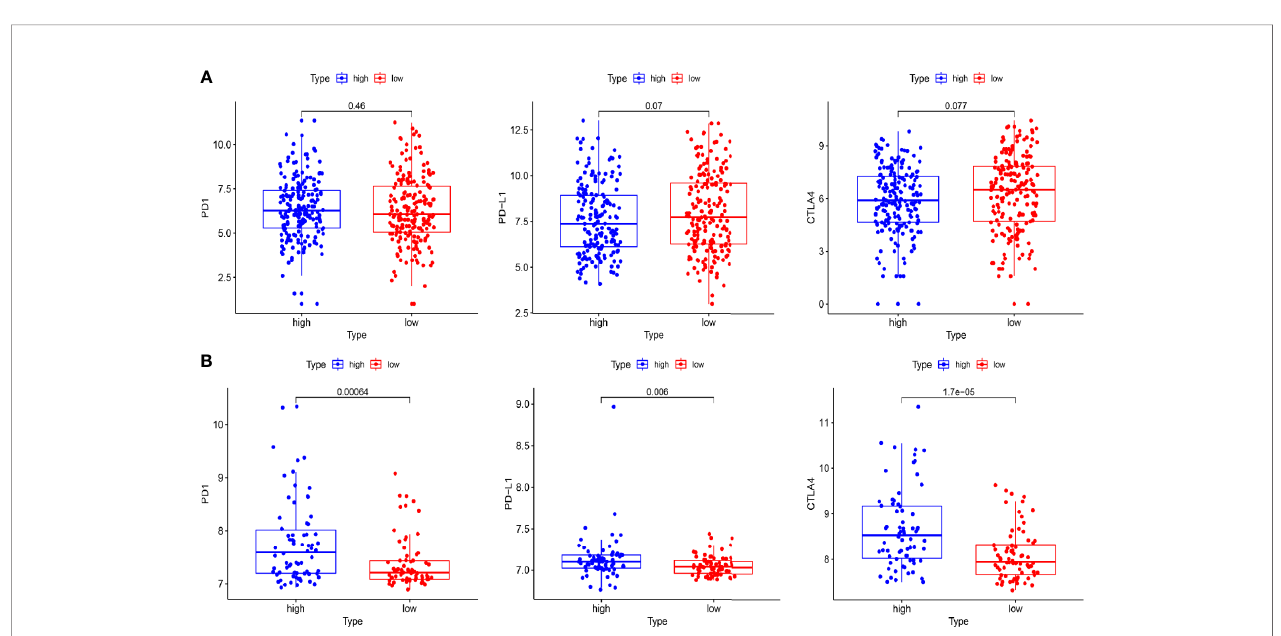
FIGURE 10 | The expression of immune checkpoint molecules including PD1, PDL1, and CTLA4 between the high-risk and the low-risk group in TCGA and GEO cohorts. (A) Box plots show the differences in the expression of PD1, PDL1, and CTLA4 between the high-risk and low-risk group in the TCGA cohort. (B) Box plots show the differences in the expression of PD1, PDL1, and CTLA4 between the high-risk and the low-risk group in the GEO cohort.